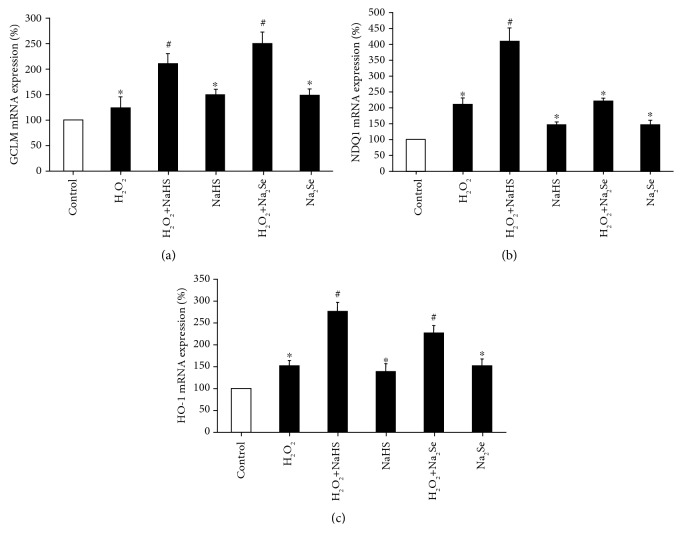
H2S/H2Se induces the mRNA expressions of Nrf2-target genes. H9C2 cells were pretreated with 30 μM NaHS or 0.3 μM Na2Se for 30 minutes, then incubated with 200 μM H2O2 for additional 24 hours followed by real-time PCR detection of GCLM (a), NDQ1 (b), and HO-1 (c) mRNA expression. ∗p < 0.05 versus control; #p < 0.05 versus H2O2. n = 3.